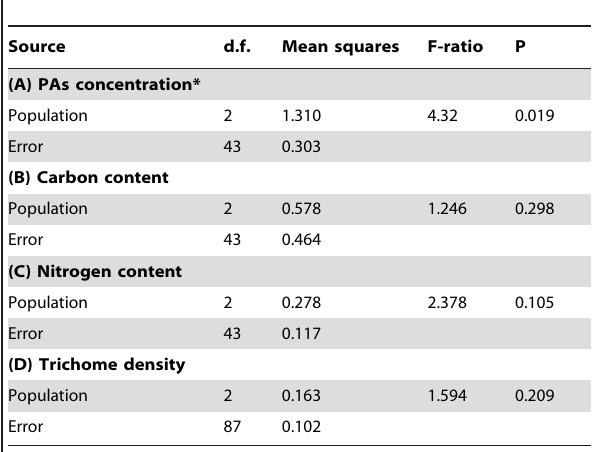
Table 3. Effect of population origin on Crotalaria pallida resistance traits at a regional scale.